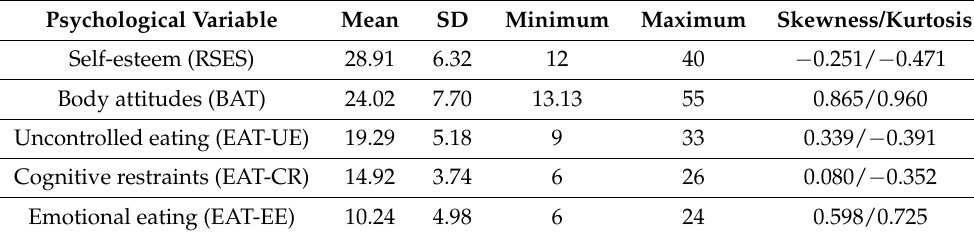
Table 1. Descriptives regarding the psychological